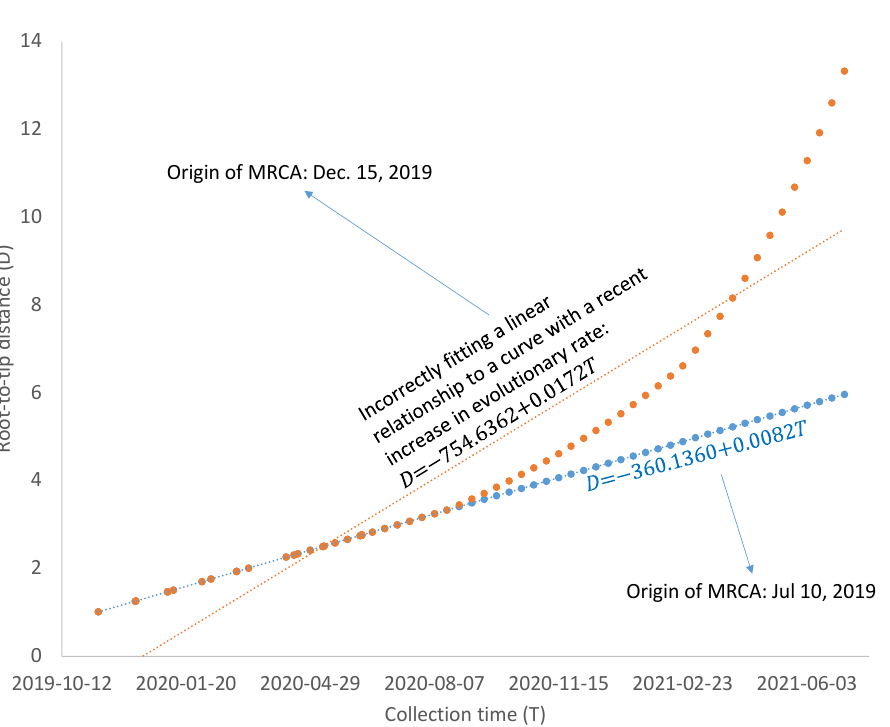
Figure 6. Illustration of bias in dating the most recent common ancestor (MRCA) of SARS-CoV-2 lineages based on Root-to-tip distance (D) and collection time (T), when the evolutionary rate has increased recently.